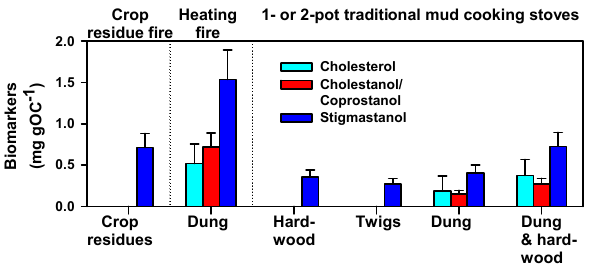
Figure 6. Emission ratios of select organic species in field tests, normalized to OC (mgg OC − 1 ) for open burning (crop residue and heating fires) and one- to two-pot traditional mud cooking stoves. Normalization to OC accounts for the large changes in EF OC ob- served across different combustion scenarios and demonstrates con- sistency in the molecular marker-to-OC ratios for common fuels. Cholesterol, cholestanol, and coprostanol are observed only when dung is